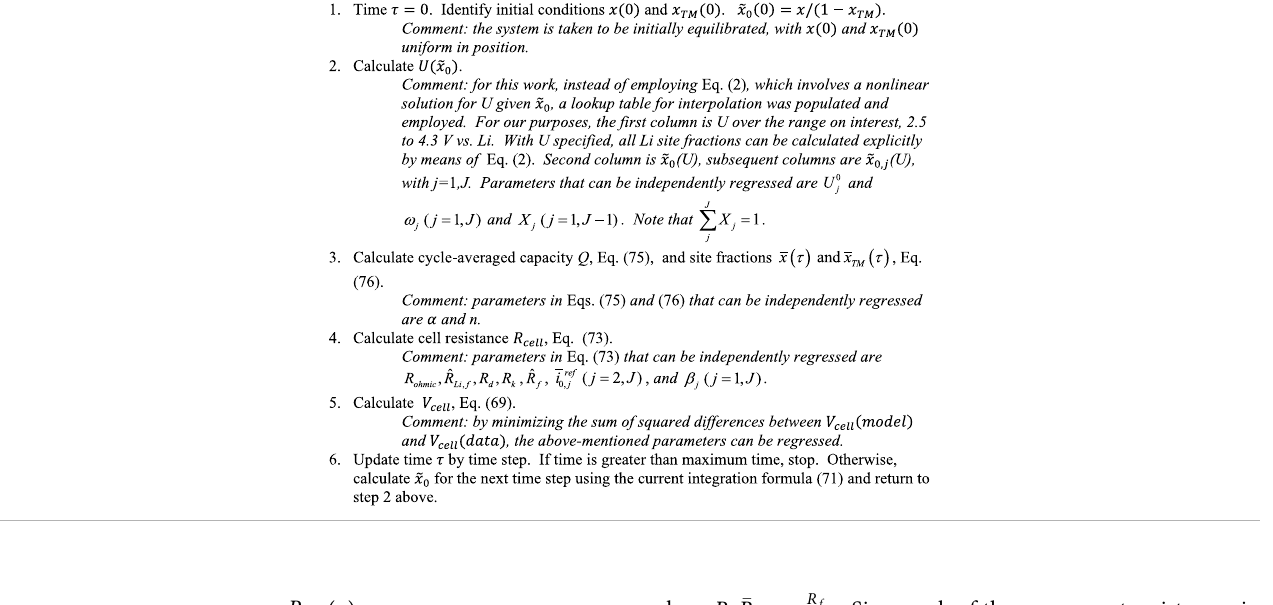
TABLE 3 | Summary of the algorithm used for the model